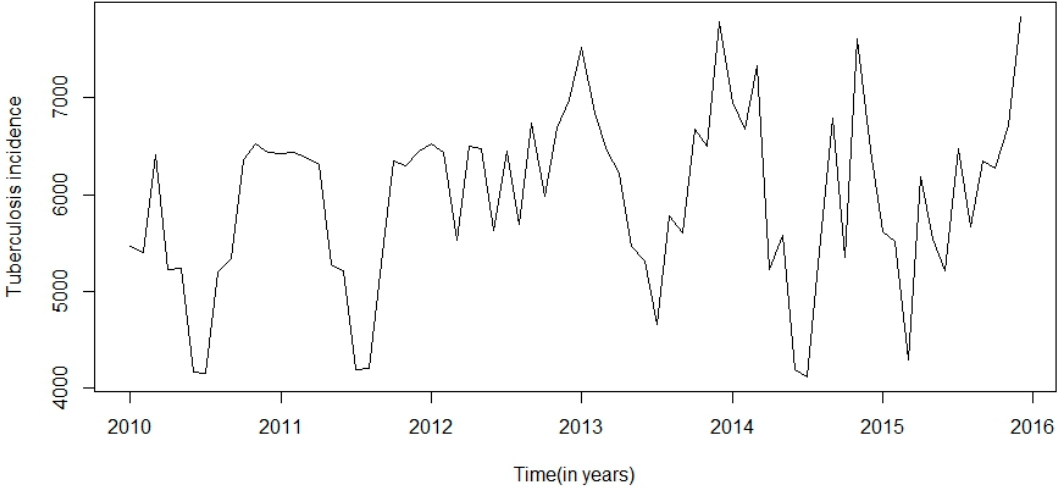
Figure 2. Monthly reported cases of TB prevalence data from 2010 to 2015.